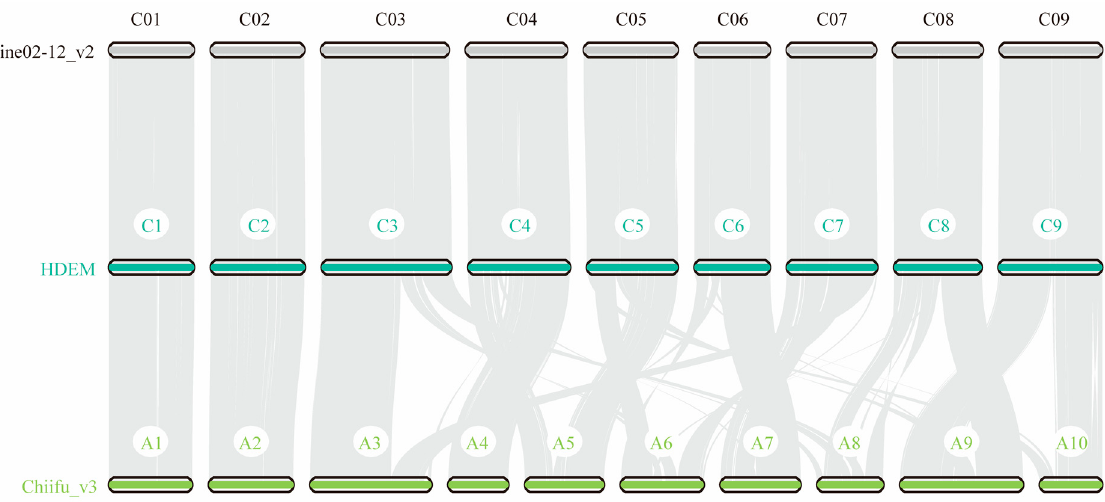
Figure 2. Chromosome-level genome alignment of the B. oleracea line02-12_v2 genome (top) and B. rapa Chiifu_v3 genome (bottom) against the HDEM genome (center).